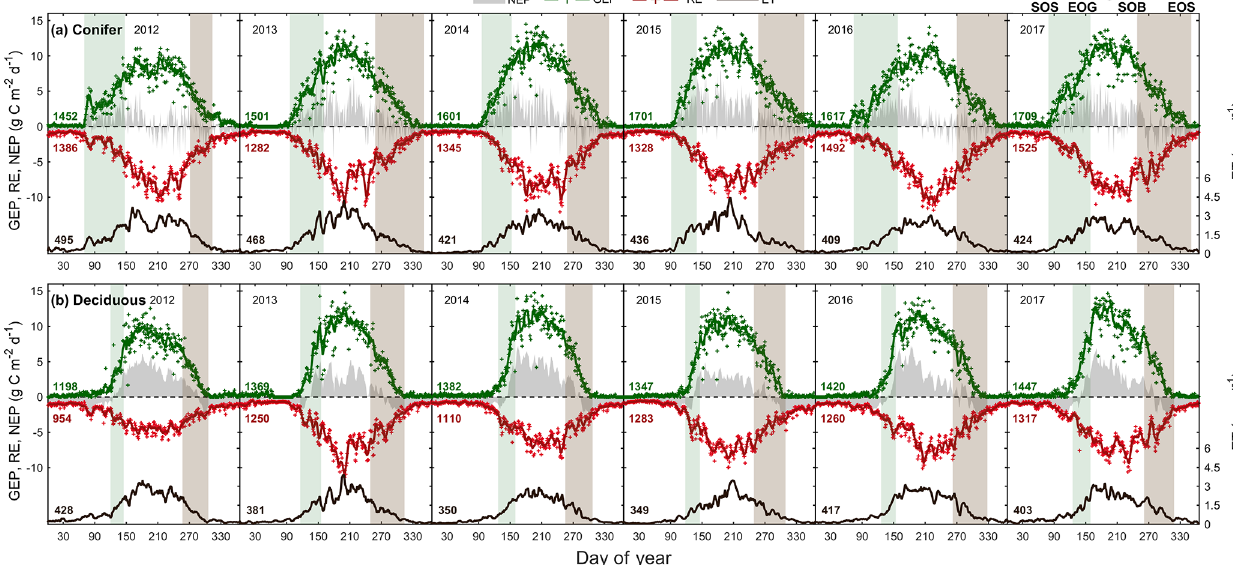
Figure 3. Time series from 2012 to 2017 of the daily total gross ecosystem productivity (GEP, green +), ecosystem respiration (RE, red +), net ecosystem productivity (NEP, grey shading), and evapotranspiration (ET, black, right) for the (a) conifer forest (TP39), and the (b) deciduous forest (TPD). Solid lines of GEP, RE, NEP, and ET are derived from 5d moving averages of the measured data, while the colored values for each year correspond to annual GEP (green), RE (red), and ET (black) for each site. The annual EC-derived phenological spring (green shading) and autumn (brown shading) are included for each site, and can be found in Table